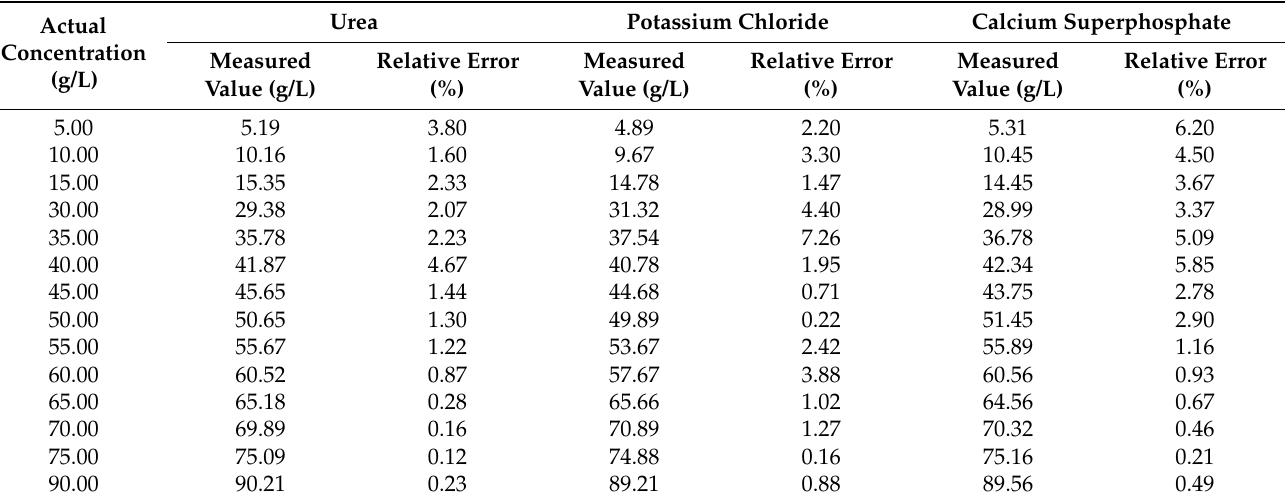
Table 1. The verification results of the detection